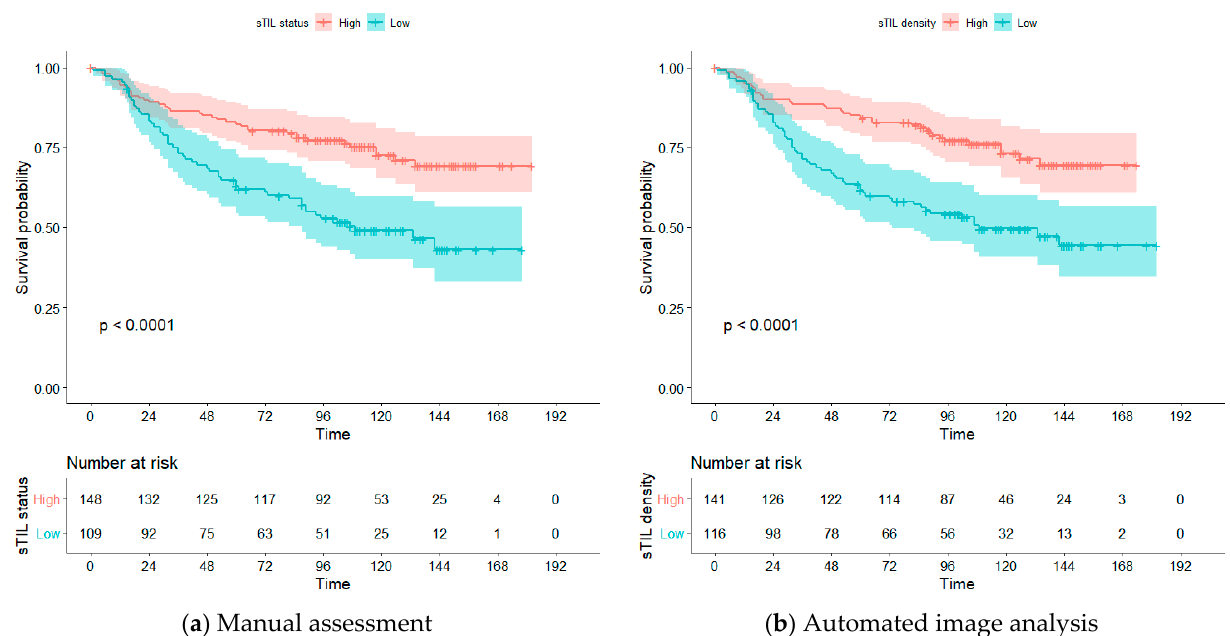
Figure 3. Overall survival estimated by Kaplan–Meier analysis. ( a ) Stratification of patients into high (red) and low (blue) group using a cutpoint of >10% on the manual sTIL status. ( b ) stratification of patients into a high (red) and low (blue) group using a cutpoint of 470 sTIL/mm 2 for the automated sTIL density.